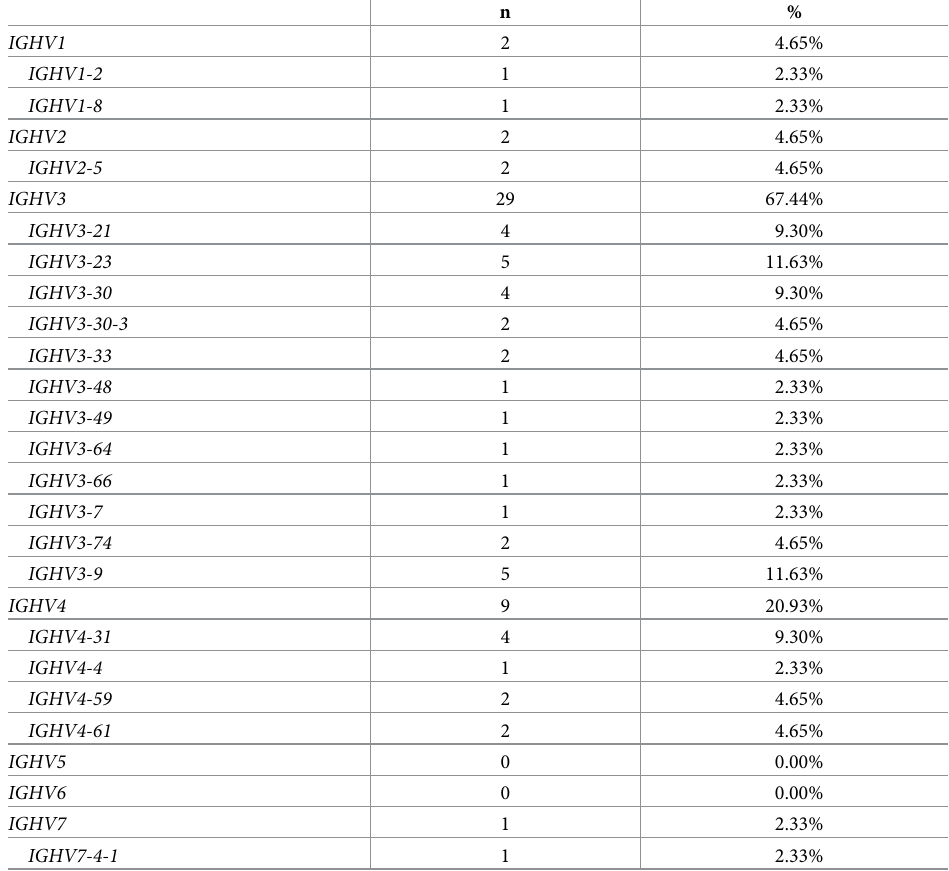
Table 3. The IGHV gene repertoire in 43 IGH rearrangements from 39 samples with clonal IGH